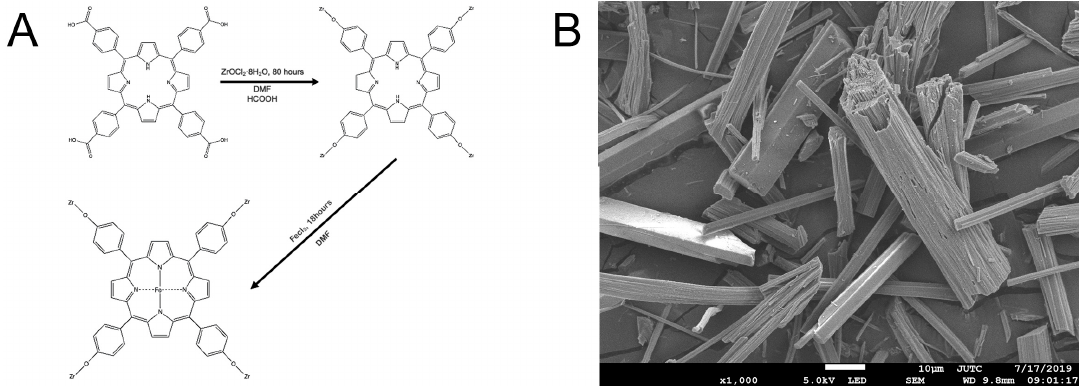
Figure 1. The synthetic graph and the SEM images of Fe-loaded MOF-545(Fe). ( A ) The synthetic process of Fe-loaded MOF-545(Fe), ( B ) the SEM images for Fe-loaded MOF-545(Fe).